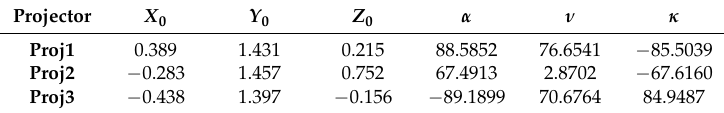
Table 7. Exterior orientation of projectors (units of translations in (m), angles in (deg)).